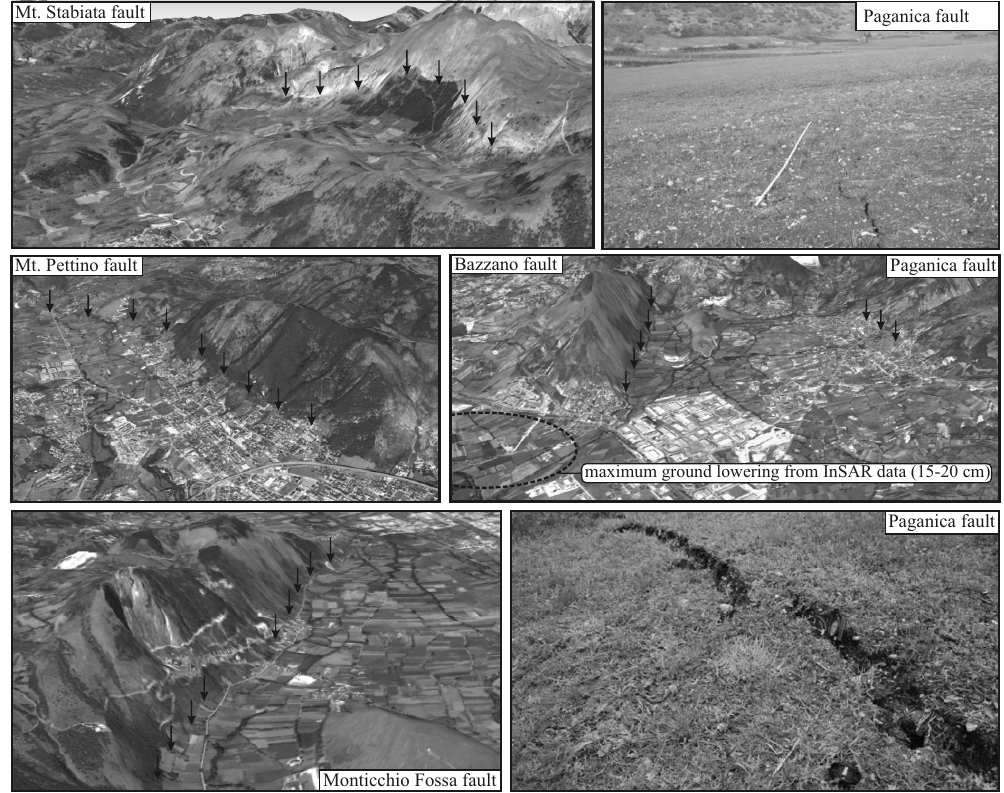
Figure 3. Landscape view of the faults in the L’Aquila area (2x vertical exaggeration). On the right the Paganica fault (central image) with two details of the surface ruptures (upper and lower panels) recognized after the 2009 earthquake (Emergeo Working Group, 2010).